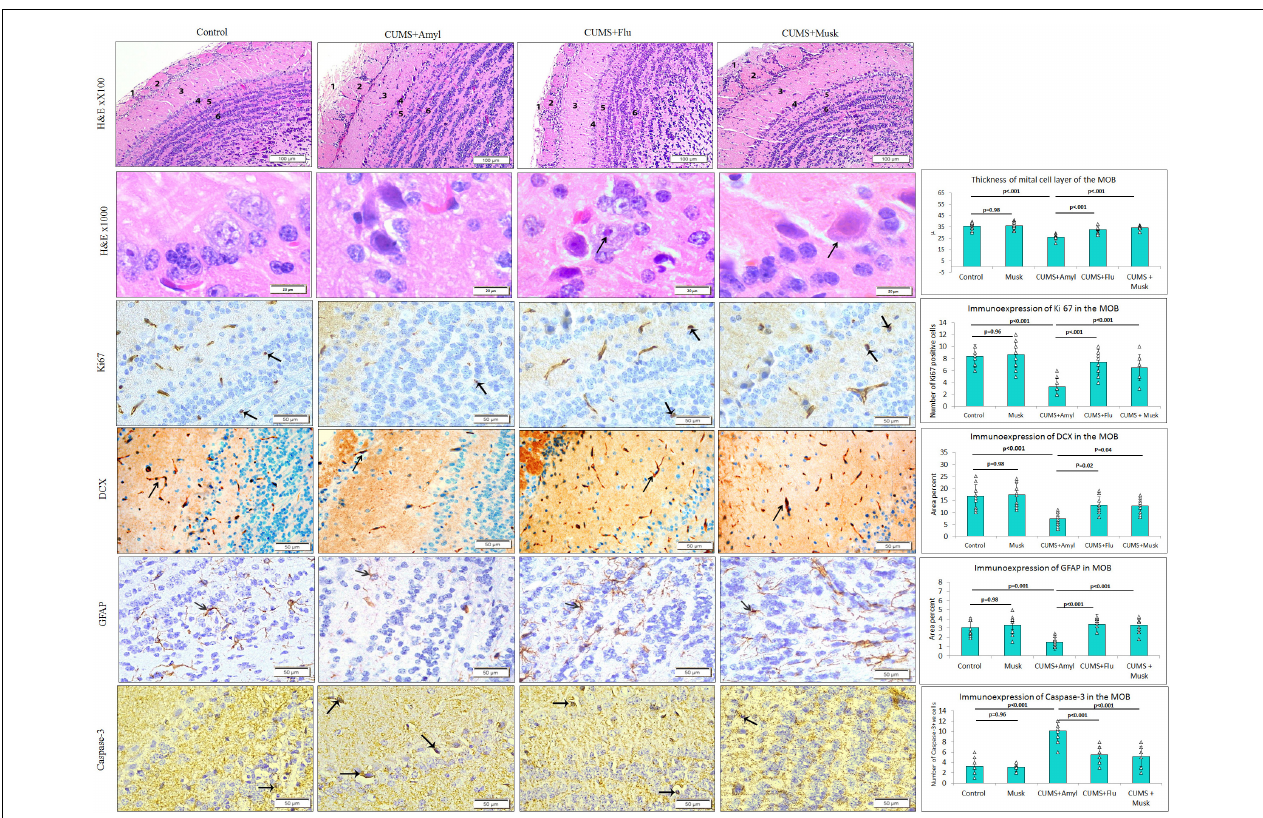
FIGURE 3 | The effect of Flu and musk on the histological structure and immunoexpression of GFAP, caspase-3, Ki67, and DCX in the main olfactory bulb (MOB) of the studied groups. The MOB shows six layers; nerve fiber layer (1), glomerular layer (2), external plexiform layer (3), mitral layer (4), internal plexiform layer (5), and granular layers (6). Note the affected mitral cells in the mitral layer indicated by the arrow and surrounded by a wide pericellular space around them (arrowhead). Data are analyzed using a mixed-model two-way ANOVA based on Bonferroni post hoc was used to analyze the data. Results are expressed as mean ± SD ( n = 10). p < 0.05 was considered significant ( df = 39). CUMS, chronic unpredictable mild stress; Flu,